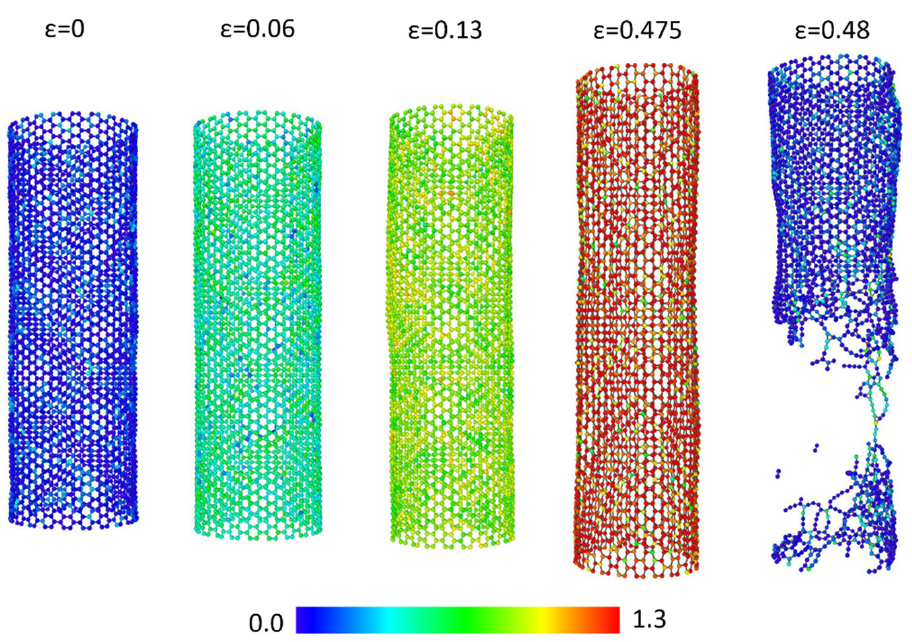
Figure 3. CNT stress field changes with the strain for SWNT-Al. The color bar represents the magnitude of the atomic stress in 10 3 GPa A 3 . The blue colored atoms shown for zero strain represent atoms holding near zero